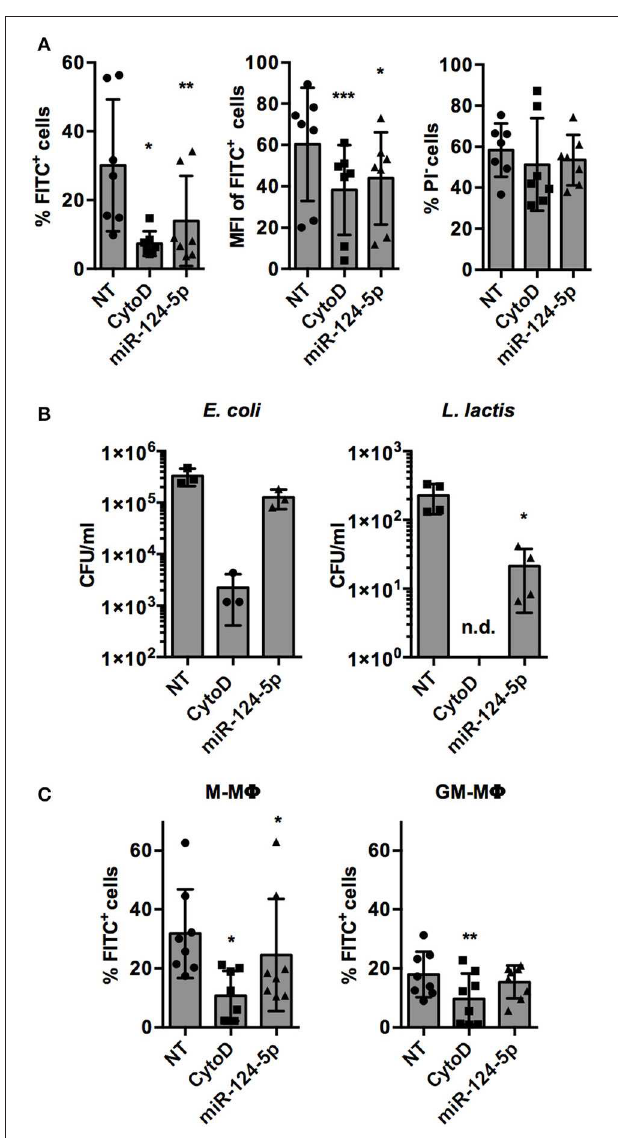
FIGURE 4 | Transfection with miR-124-5p reduces phagocytosis of opsonized latex beads and live bacteria in PMA-activated THP-1 M 8 and ex vivo differentiated, primary M- and GM- M 8 . (A) Phagocytosis of FITC-labeled, opsonized latex beads by PMA-activated THP-1 M 8 treated with an NT siRNA (NT), cytochalasin D (CytoD), or miR-124-5p as percentage of phagocytic cells (% FITC + cells, left), phagocytic activity (MFI of FITC + cells, middle), and viability (% PI − cells) across n = 6 independent experiments. (B) Phagocytosis of live E. coli (left panel) or L. lactis (right panel) in the same experimental setup assessed as intracellular colony-forming units (CFU/ml) by gentamicin protection assay ( n = 3–4 independent experiments). (C) Phagocytosis of FITC-labeled, opsonized latex beads by ex vivo differentiated M-M 8 (left panel) and GM-M 8 (right panel) with the indicated treatments as percentage of phagocytic cells (% FITC + cells; n = 8 donors). In all panels, values from each experiment are indicated by symbols and the mean ± SD are indicated by a bar and whiskers (n.d.: not detected). Statistical analysis was performed using repeated measures, one-way ANOVA with Geisser–Greenhouse correction. Dunnett’s post analysis was used to calculate p -values adjusted for multiple comparisons with the NT set as control condition (* p < 0.05; ** p < 0.01; *** p <